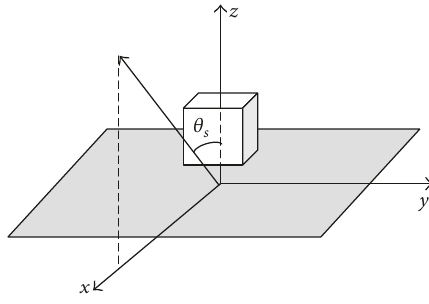
Figure 8: Illustration of a cube on flat plate.